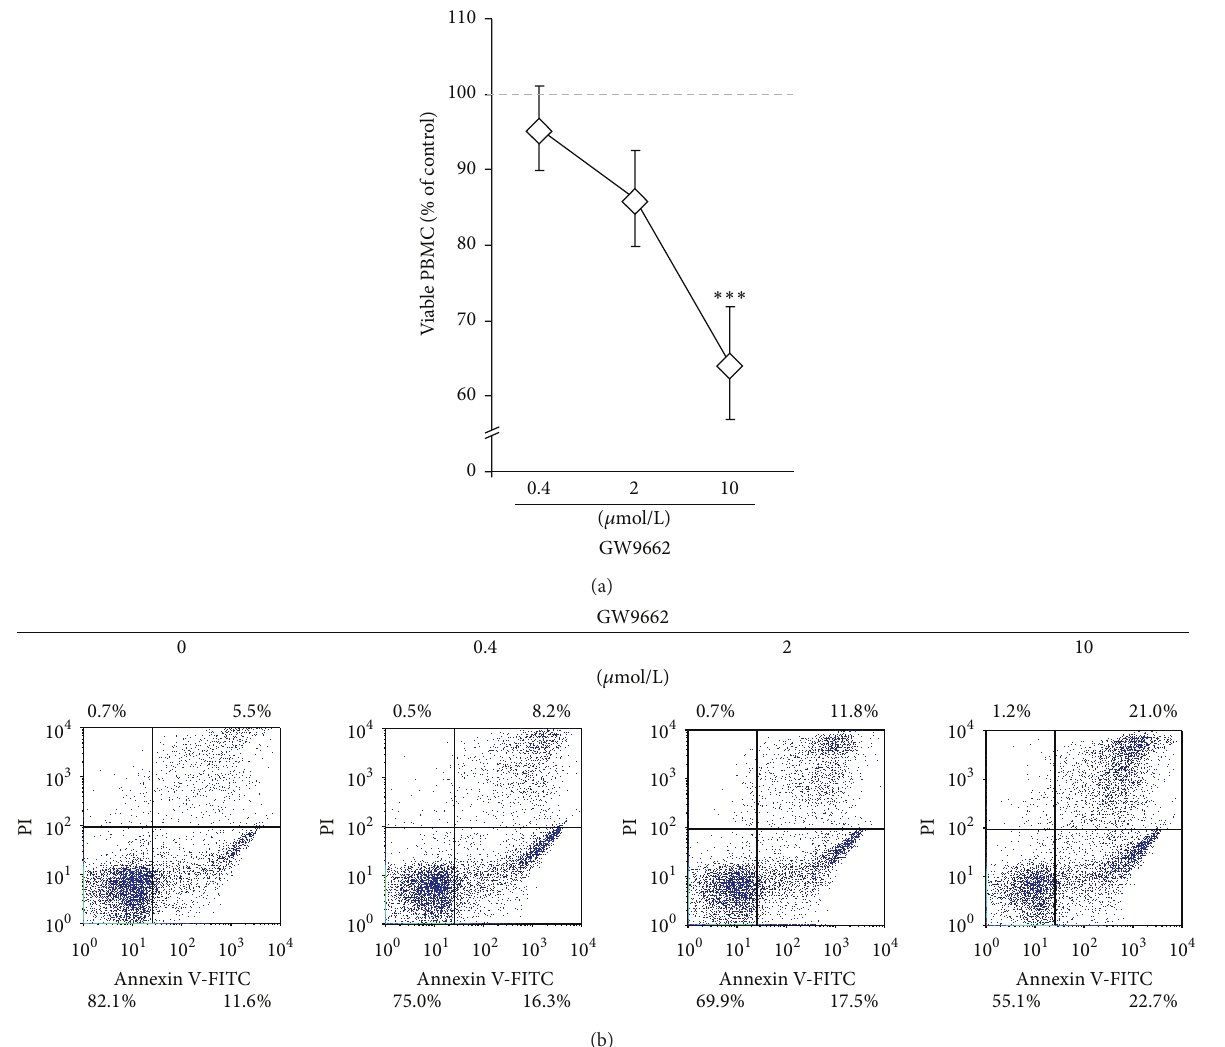
Figure 3: GW9662 dose-dependently causes cell death in leukocytes. PBMC were incubated for a total of 24 h with increasing concentrations of GW9662. After 19 h, stimulants were added for further 5 h. Cell viability was flow cytometrically assessed by annexin-V and propidium iodide exclusion double staining and is expressed as % of control without GW9662 (dotted line). Annexin-V positive and PI negative cells were defined as early apoptotic cells; annexin-V positive and PI positive cells were defined as late apoptotic and necrotic cells. (a) Data are expressed as means ± SEM of 𝑛 = 4 . The dose-dependent effect is statistically significant with ∗∗∗ 𝑃 < 0.001 . (b) Representative dot plots of GW9662 treated PBMC, gated for